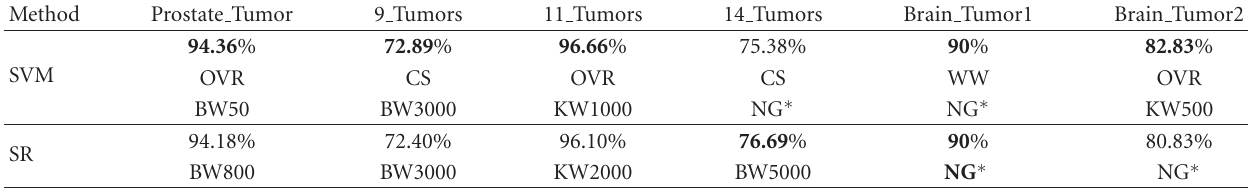
Table 2: Results with gene